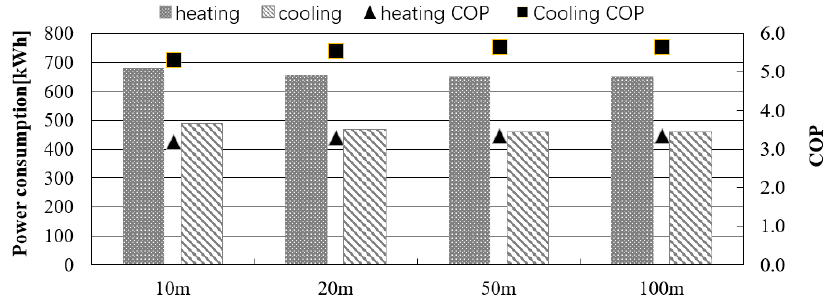
Figure 12. Electric power consumption and average COPs for different length of GHE. (Effective thermal conductivity 1.5 W/m.K).